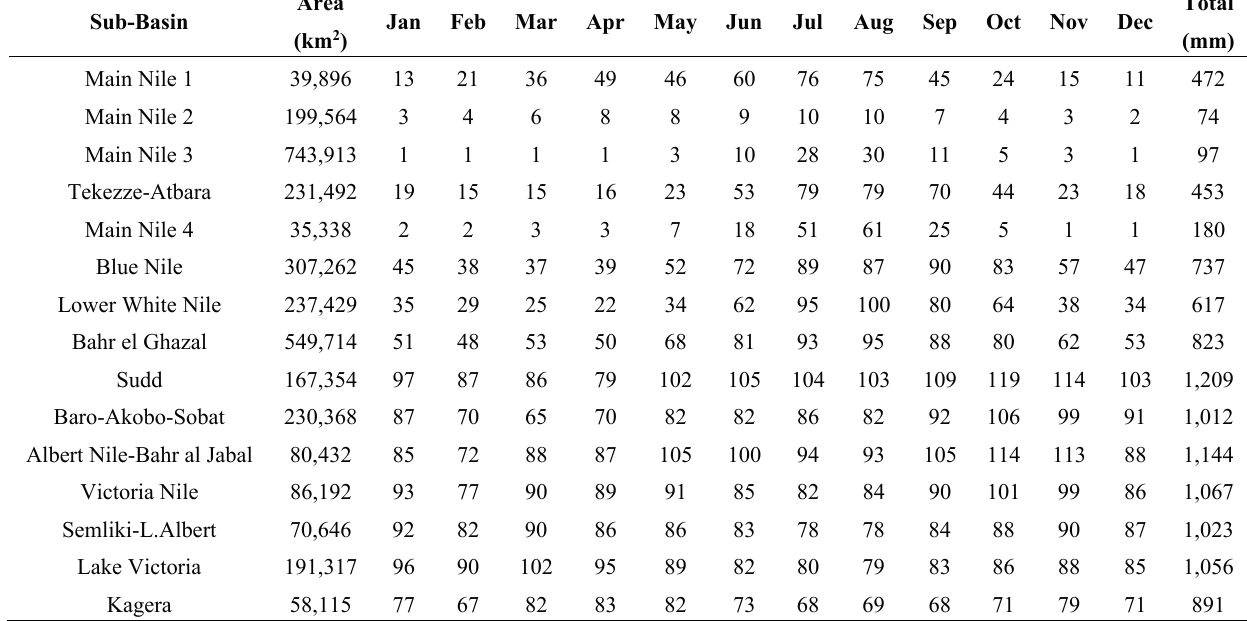
Table 2. Monthly actual evapotranspiration (including interception) from the calibrated SSEBop model (mm/month). The update is based on a bias factor and a correction term for “interception energy” during periods when the land surface contains a water film and